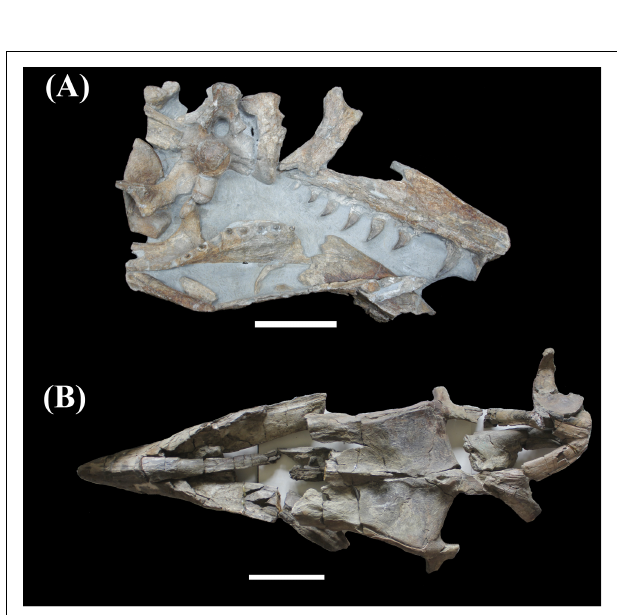
FIGURE 7 | Specimens assigned to the genus Taniwhasaurus . (A) Ta. oweni KHM N99-1014/1-5; (B) Ta. antarcticus (holotype) IAA 2000-JR-FSM-1. Scale bars equal to 100